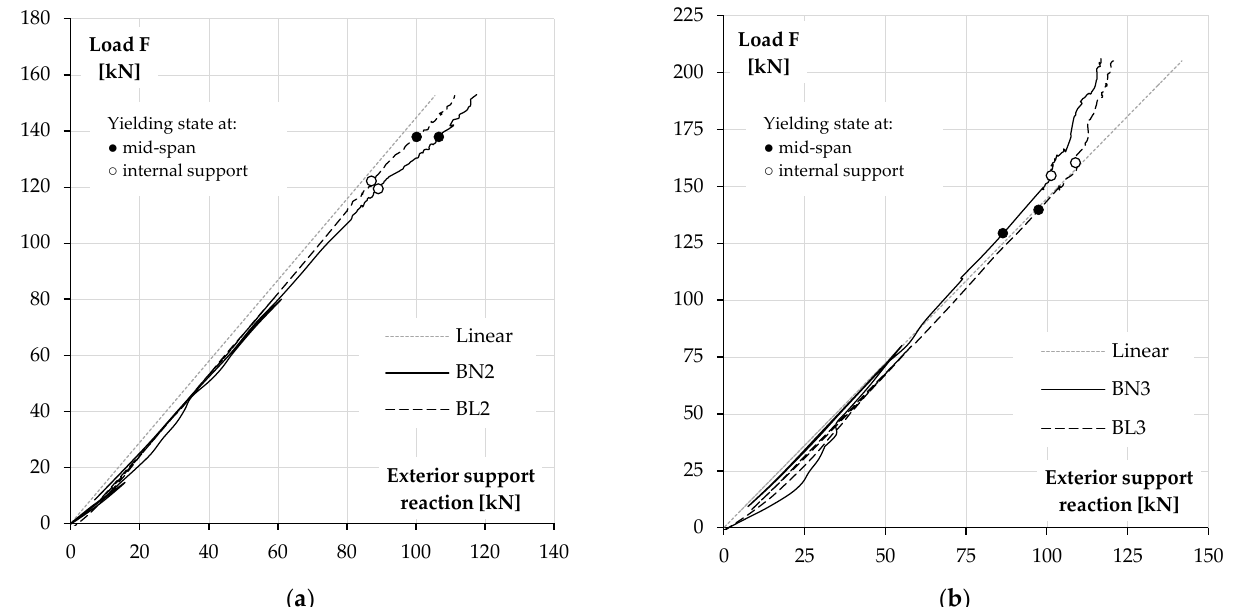
Figure 13. Load redistribution at exterior support in the second group (BN2 and BL2) ( a ) and the third group (BN3 and BL3) ( b ).